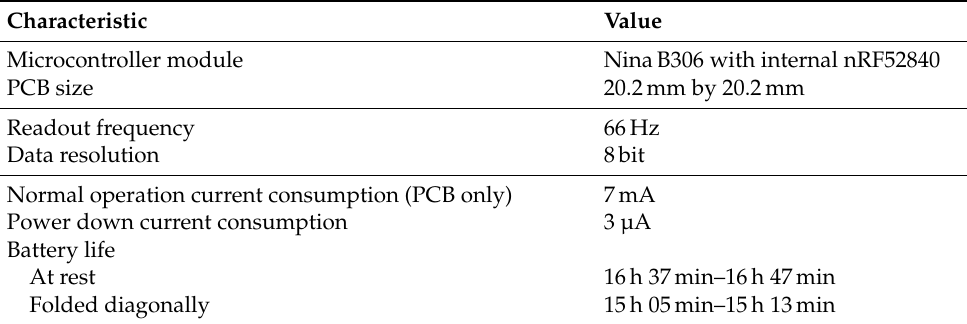
Table 1. Technical specifications of the smart